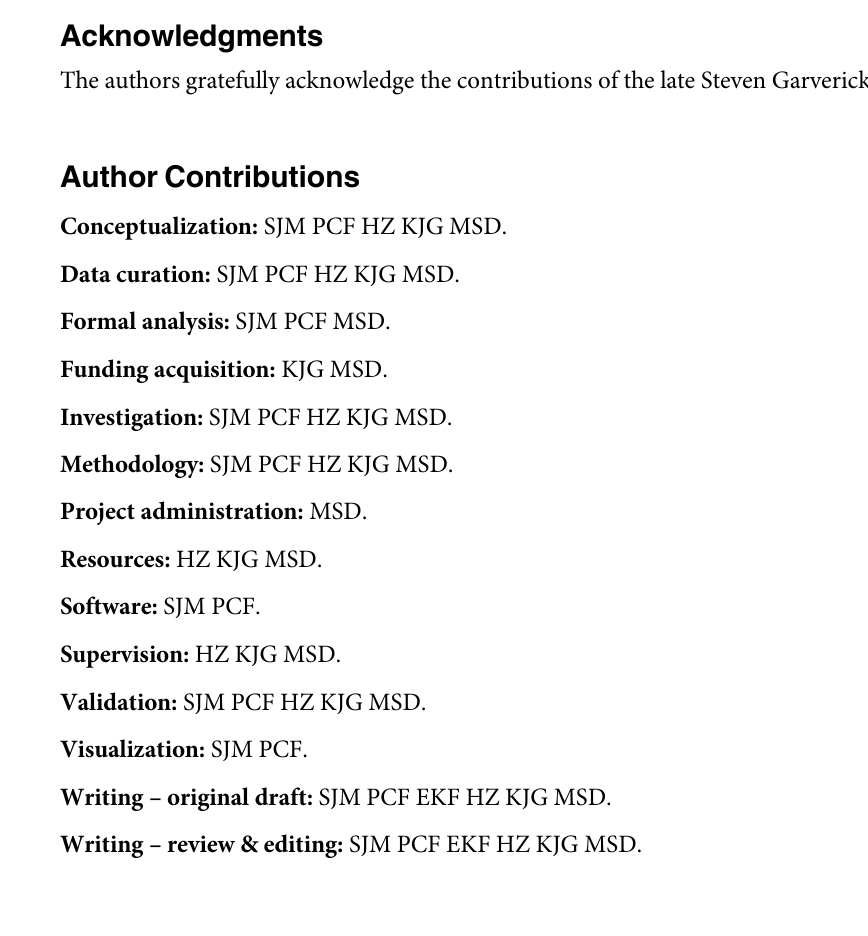
S1 Table. Correlation coefficients extracted from 10-s windows of raw data. These data are plotted as boxplots in Fig